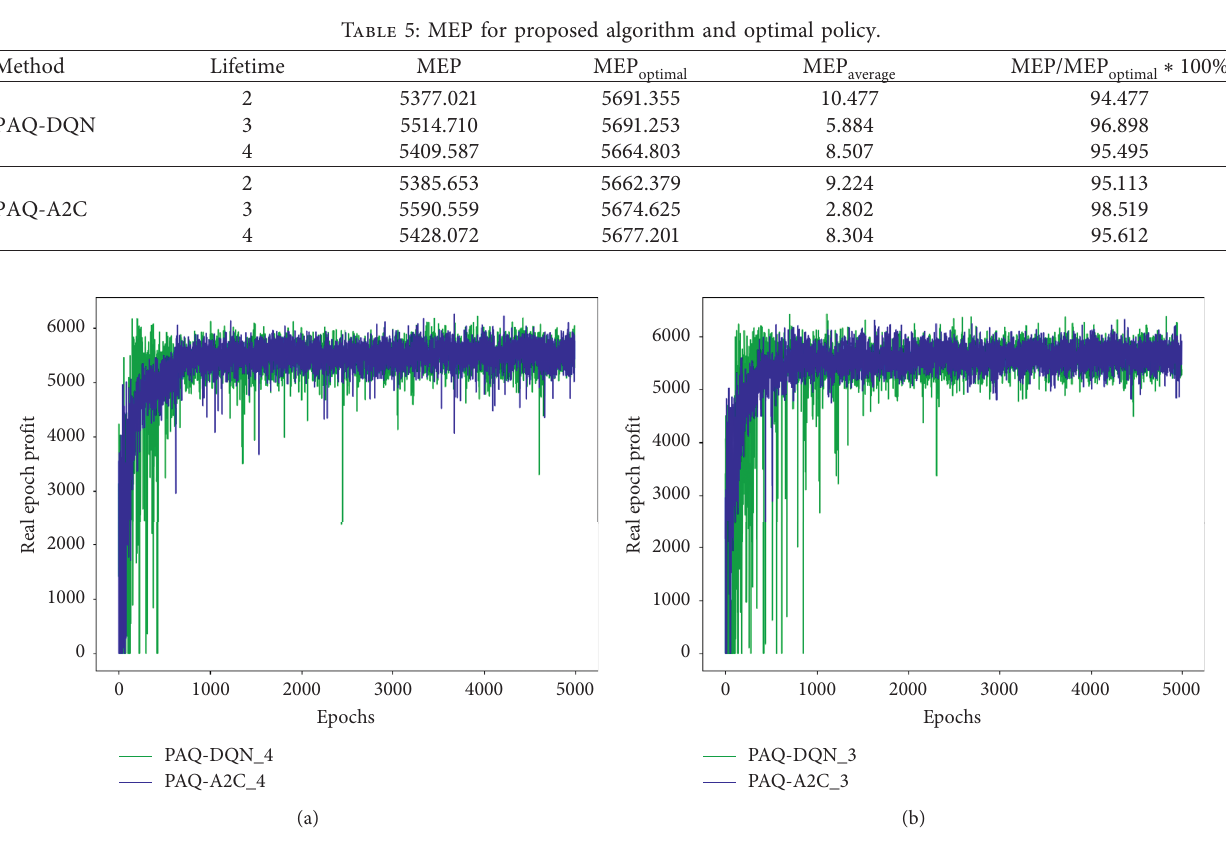
Figure 1: Real epoch profits for PAQ-DQN and PAQ-A2C, where the lifetime 3 and lifetime 4 are shown.